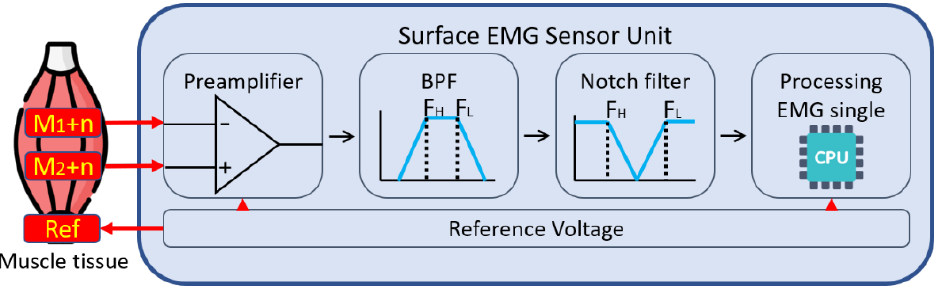
Figure 2. Surface EMG measurement sensor block diagram. The EMG signal is represented by ‘M’ and the noise signals by ‘n’.